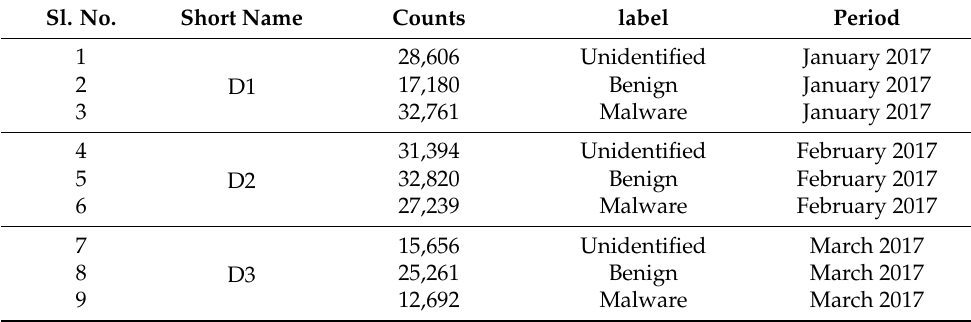
Table 3. Details of D1, D2, D3 datasets.